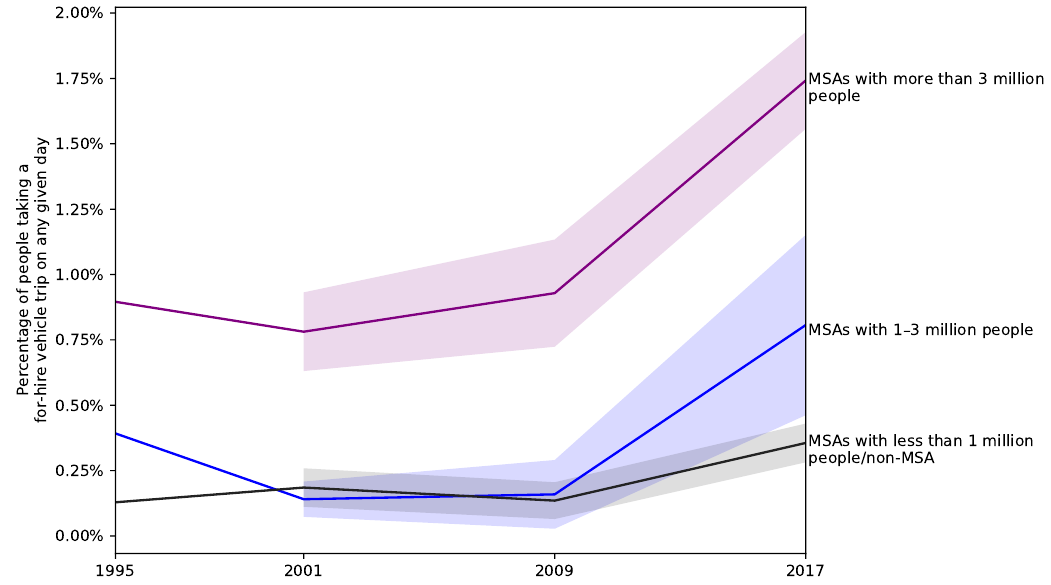
Figure 2. Per capita use of for-hire vehicles, by metropolitan area size (shaded areas represent 95% confidence